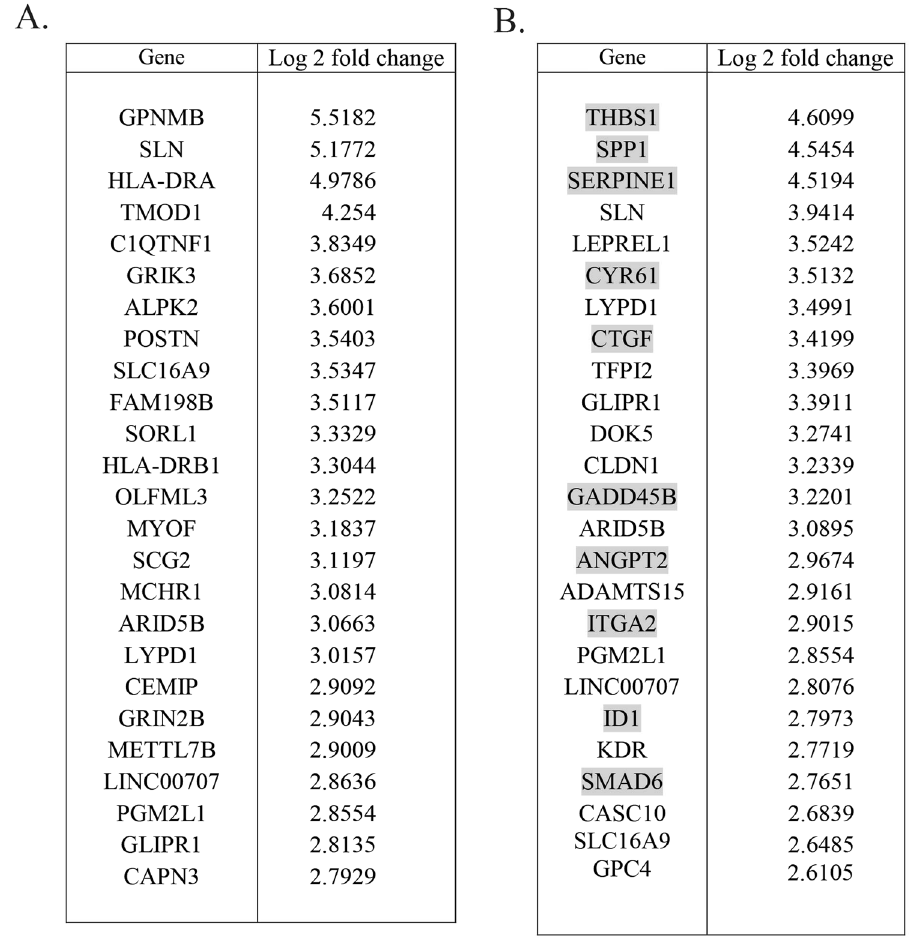
Figure 4. Long term and short term effects of serum on gene expression. PriGO8A cells were treated without or with 10% serum for either seven days ( A ) or 24 h ( B ). RNA was then isolated and microarray expression analysis performed. The 25 genes showing the largest increases in expression with serum are shown. In ( B ), genes that have previously been shown to be regulated by TGF β are highlighted in